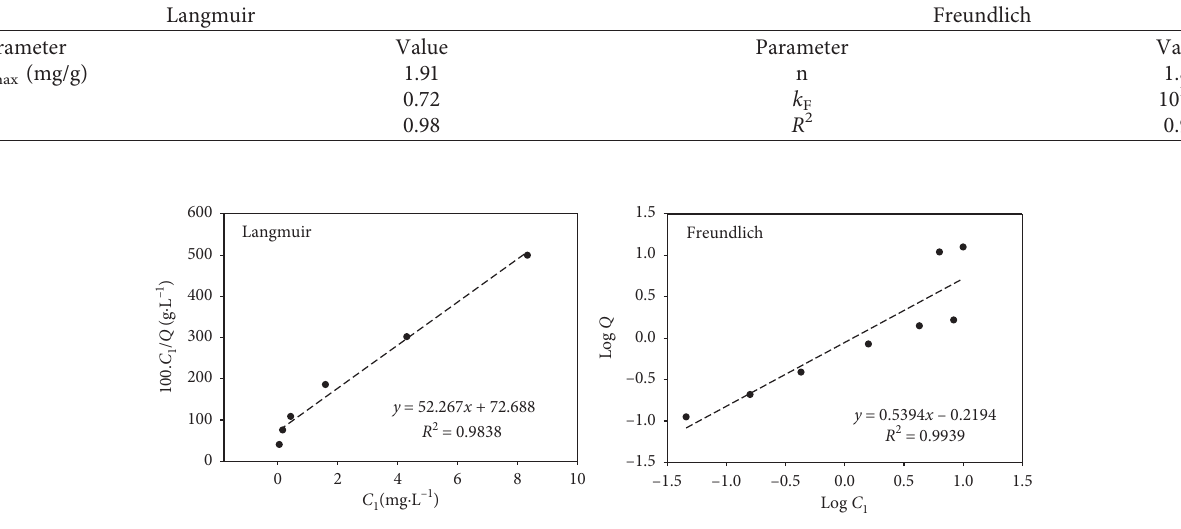
2+ and Cd 2+ ions.